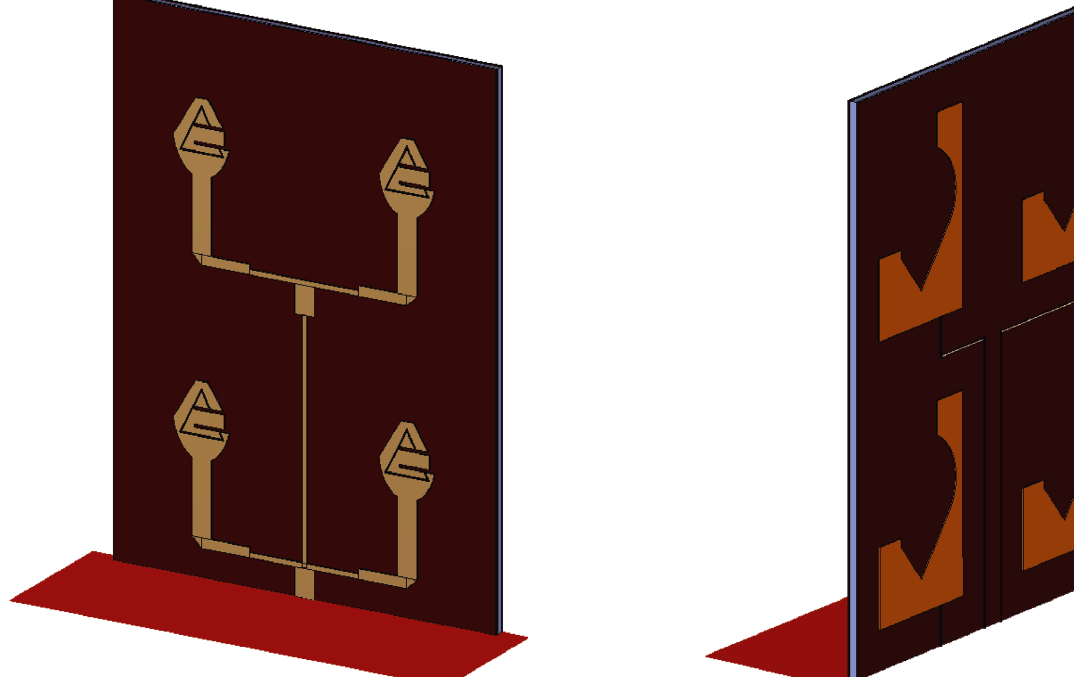
Figure 23: 3D view 2 × 2 array with the